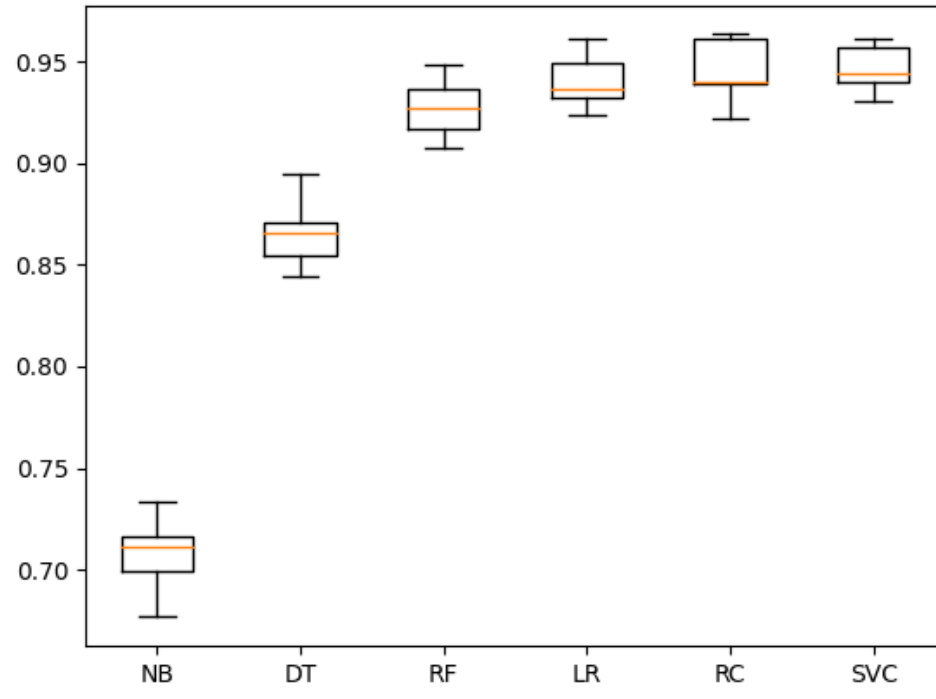
Figure 5. Box plot of all classifiers against the score